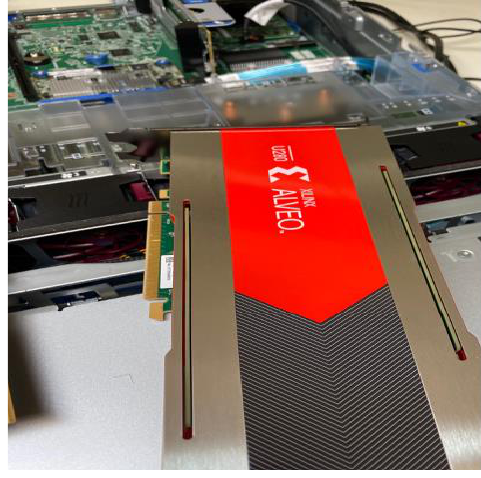
Figure 7. Xilinx Alveo U280 accelerator card.